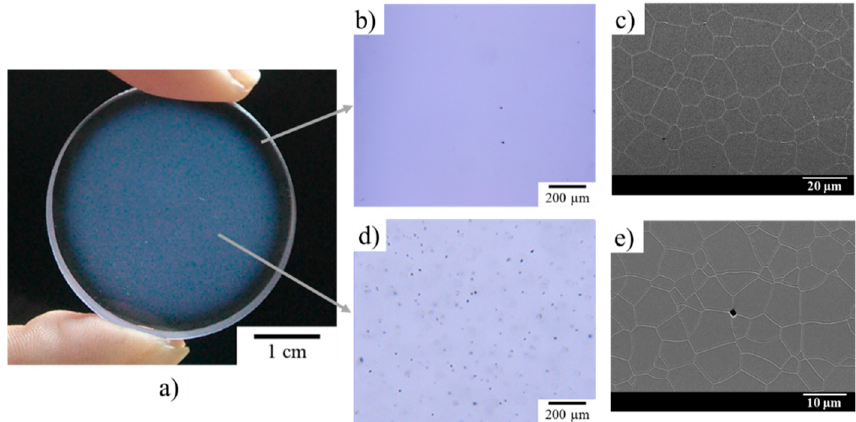
Figure 9. View of 1 at.% Nd:YAG ceramic with a 10 mm thickness obtained by pressure slip-casting and natural vacuum sintering at 1740 °C for 20 h. ( a ) Sample picture; Optical micrographs of ( b ) the shell and ( d ) the core; SEM micrographs of ( c ) the shell and ( e ) the core. The mean grain diameter is 18.5 ± 0.5 µm and 6.6 ± 0.2 µm at the edge and in the core of the